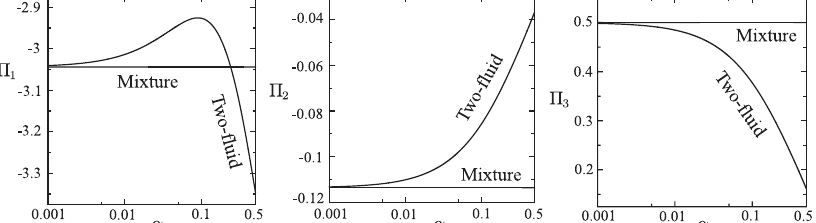
Fig. 2 The nonlinear coe ffi cient Π 1 , dissipation coe ffi cient Π 2 , and dispersion coe ffi cient Π 3 as functions of the initial void fraction α 0 in the case of Ω = 1, √ (cid:3) = 0 . 15, R ∗ = 10 μ m, p ∗ = 101325Pa, ρ ∗ = 10 3 kg / m 3 , σ ∗ = 0 . 0728N / m, 0 L0 L0 = 1 . 5 × 10 3 m / s, μ ∗ = 10 − 3 Pa · s, γ = 1, and β = β = 1 / 2. The c ∗ 1 2 L0 curves represent the coe ffi cients Π 1 , Π 2 , and Π 3 in the two-fluid model, and the corresponding coe ffi cients in a bubble–liquid mixture model are shown by the straight lines. The initial number density of bubbles varies with the variation of ∗ α is 0 since R 0